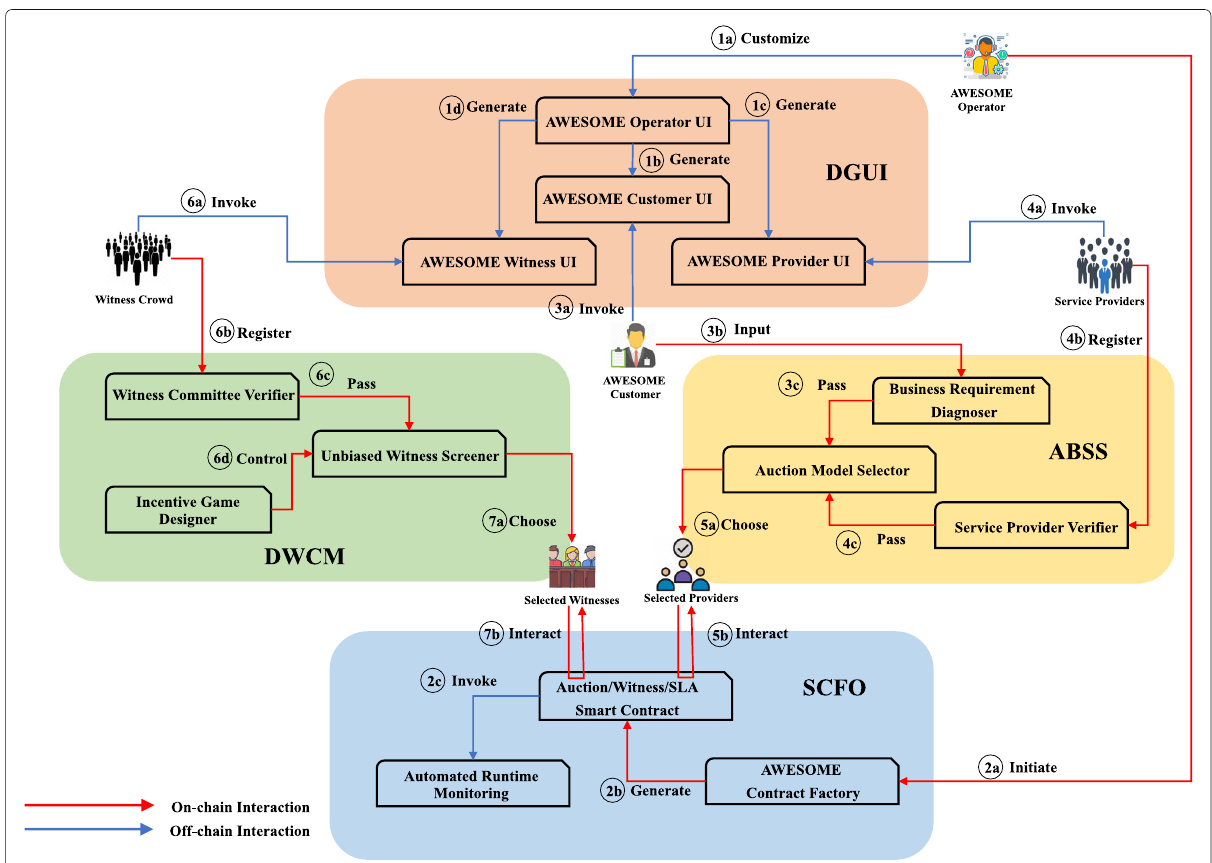
Fig. 3 The process flow of the AWESOME model and the related stakeholders in the decentralized service ecosystem